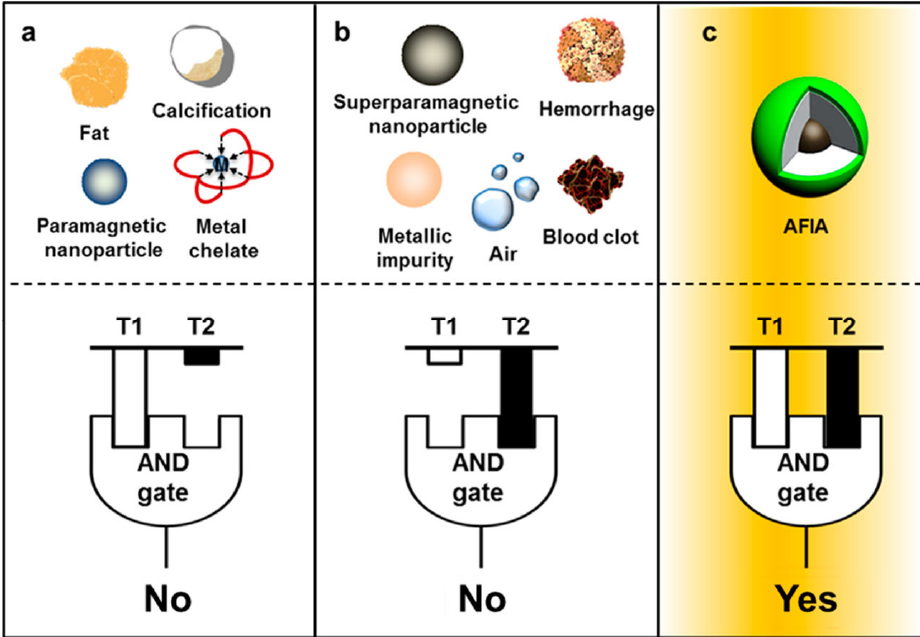
Figure 16. Illustration of artifacts and typical contrast agents that give high MRI contrast effects in either T 1 or T 2 but do not satisfy AND logic ( a , b ) and artifact filtering imaging agent (AFIA) that fulfills AND logic ( c ) (reprinted from [153] with permission of ©2014 American Chemical Society).